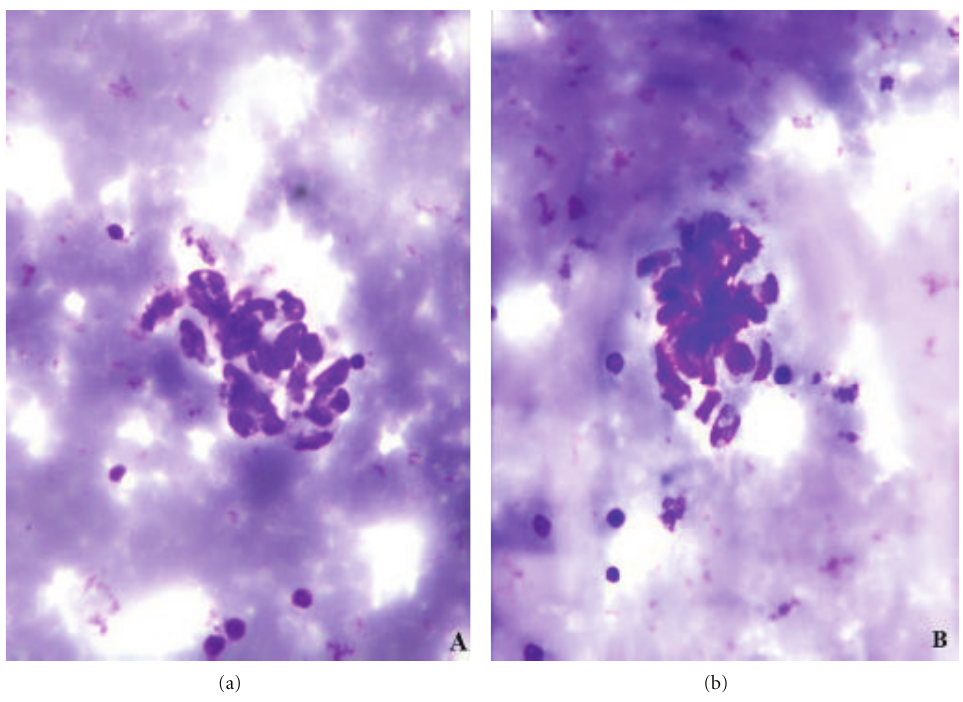
Figure 3: Cytosmear showing loosely cohesive clusters comprising cells with oval to spindle nuclei ((a) and (b)) (40x, MGG).